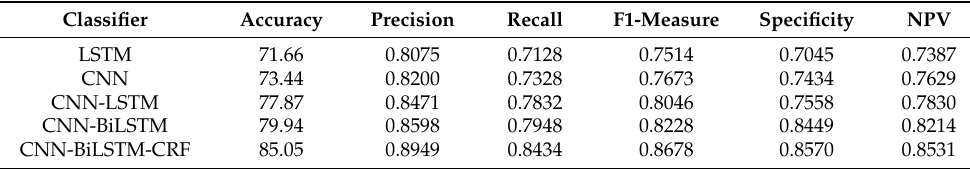
Table 6. The mean classification performance metrics with a 10-fold cross-validation technique across all participants in Experiment 2. Ten test runs were performed on each model, and the average of the results was